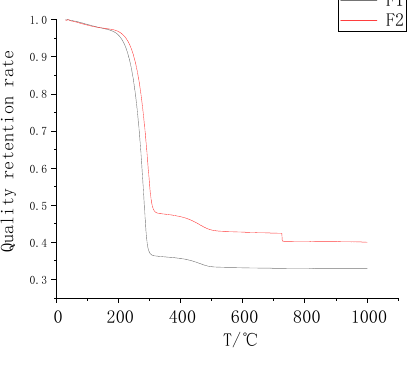
Figure 6. F1 andF2 TGA diagrams.